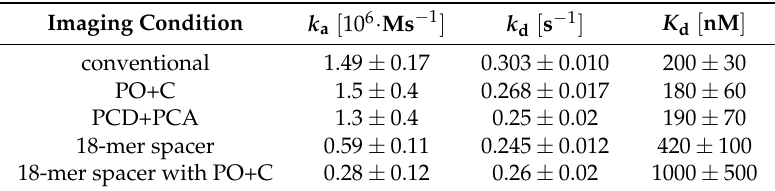
Table 1. Binding kinetics as measured by SI-FCS titrations of the imager concentrations Hybridization rates and affinity as obtained from the titrations in Figure 4. The errors represent the 95% confidence bounds of the